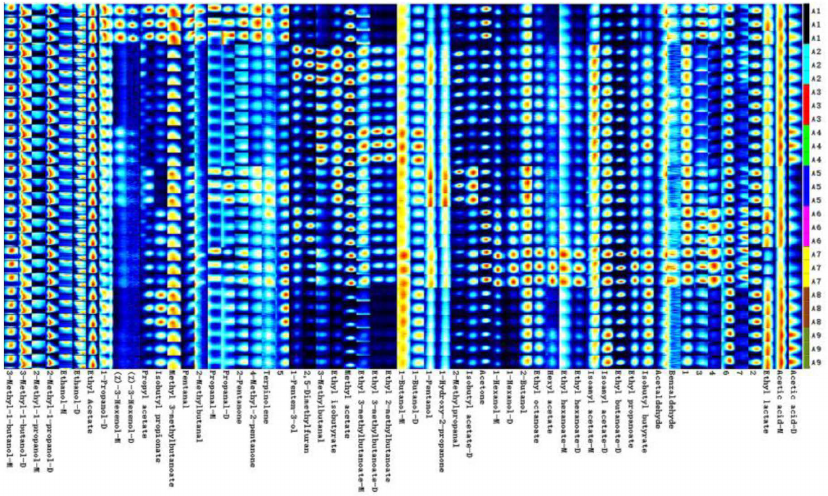
Figure 4. Fingerprints of volatile compounds in different wine varieties. Note: From A1 to A9 are ‘Hassan’, ‘Zuoshaner’, ‘Beibinghong’, ‘Zuoyouhong’, ‘Beta’, ‘Shuanghong’, ‘Zijingganlu’, ‘Cabernet Sauvignon’, and